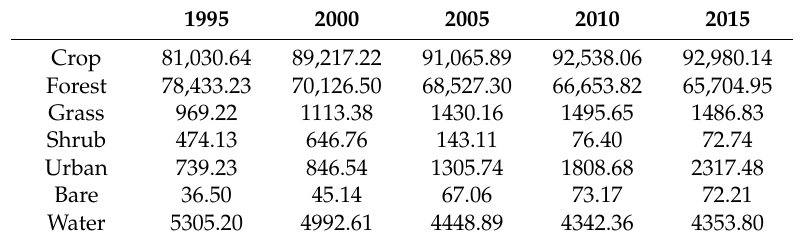
Table 3. Hectares of land cover types in Jiangxi province from 1995 to 2015 (unit: km 2 ).